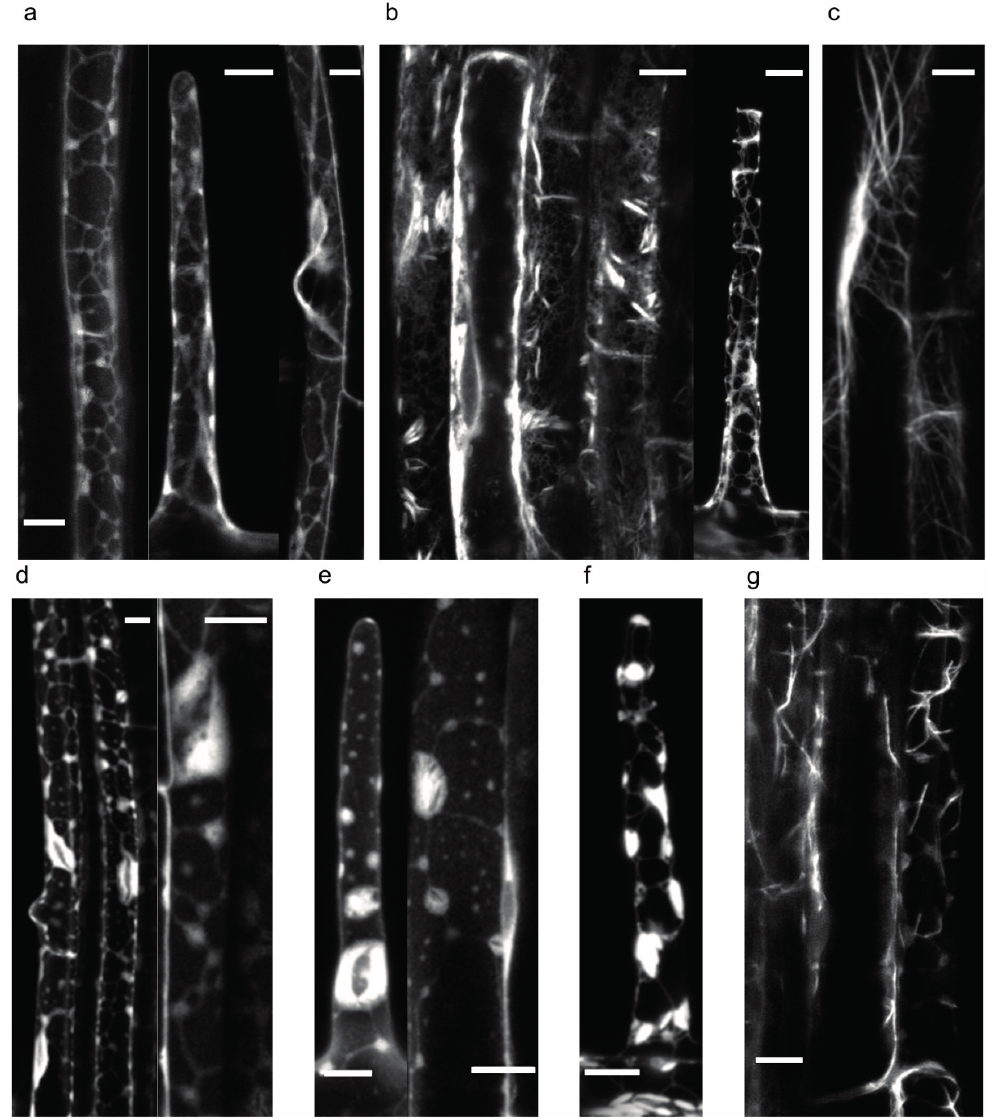
Figure 3. Arabidopsis Class II formin AtFH16 (At5g07770) associates with the ER in the rhizodermis of young seedlings stably transformed with a plasmid carrying full-length AtFH16 C, terminally tagged with GFP under the control of the 35S promoter. ( a ) From left to right : AtFH16:GFP in a root hair, an atrichoblast, and a bulge-stage trichoblast; ( b ) The ER marker GFP:HDEL in a control line shows a similar, though more detailed, pattern, with some bright ER bodies. Left —a segment of rhizodermis, right —a root hair; ( c ) The actin cytoskeleton, visualized by GFP:FABD in the rhizodermis of another control line, exhibits a different pattern; ( d – g ) Sister seedlings after LatB treatment (10 μ M for the time indicated). ( d ) AtFH16:GFP after 2 h; ( e ) AtFH16:GFP after 4 h; ( f ) GFP:HDEL after 2 h; ( g ) GFP:FABD after 2 h (note actin fragmentation). Scale bars represent 10 μ m. Modified from